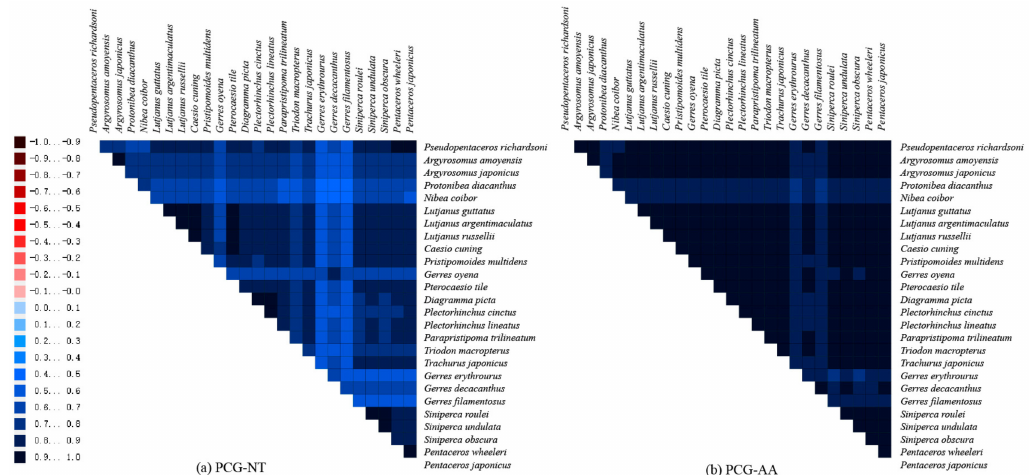
Figure 7. ( a ) AliGROOVE analysis of 13 PCGs for 26 mitochondrial genomes considering their nucleotide composition. ( b ) AliGROOVE analysis based on amino acid composition of 13 PCGs. The obtained mean similarity score between sequences is represented by a colored square. The site scores are ranging from − 1, indicating great di ff erence in sequence composition (red coloring), to + 1, indicating similarity to other sequence composition (blue